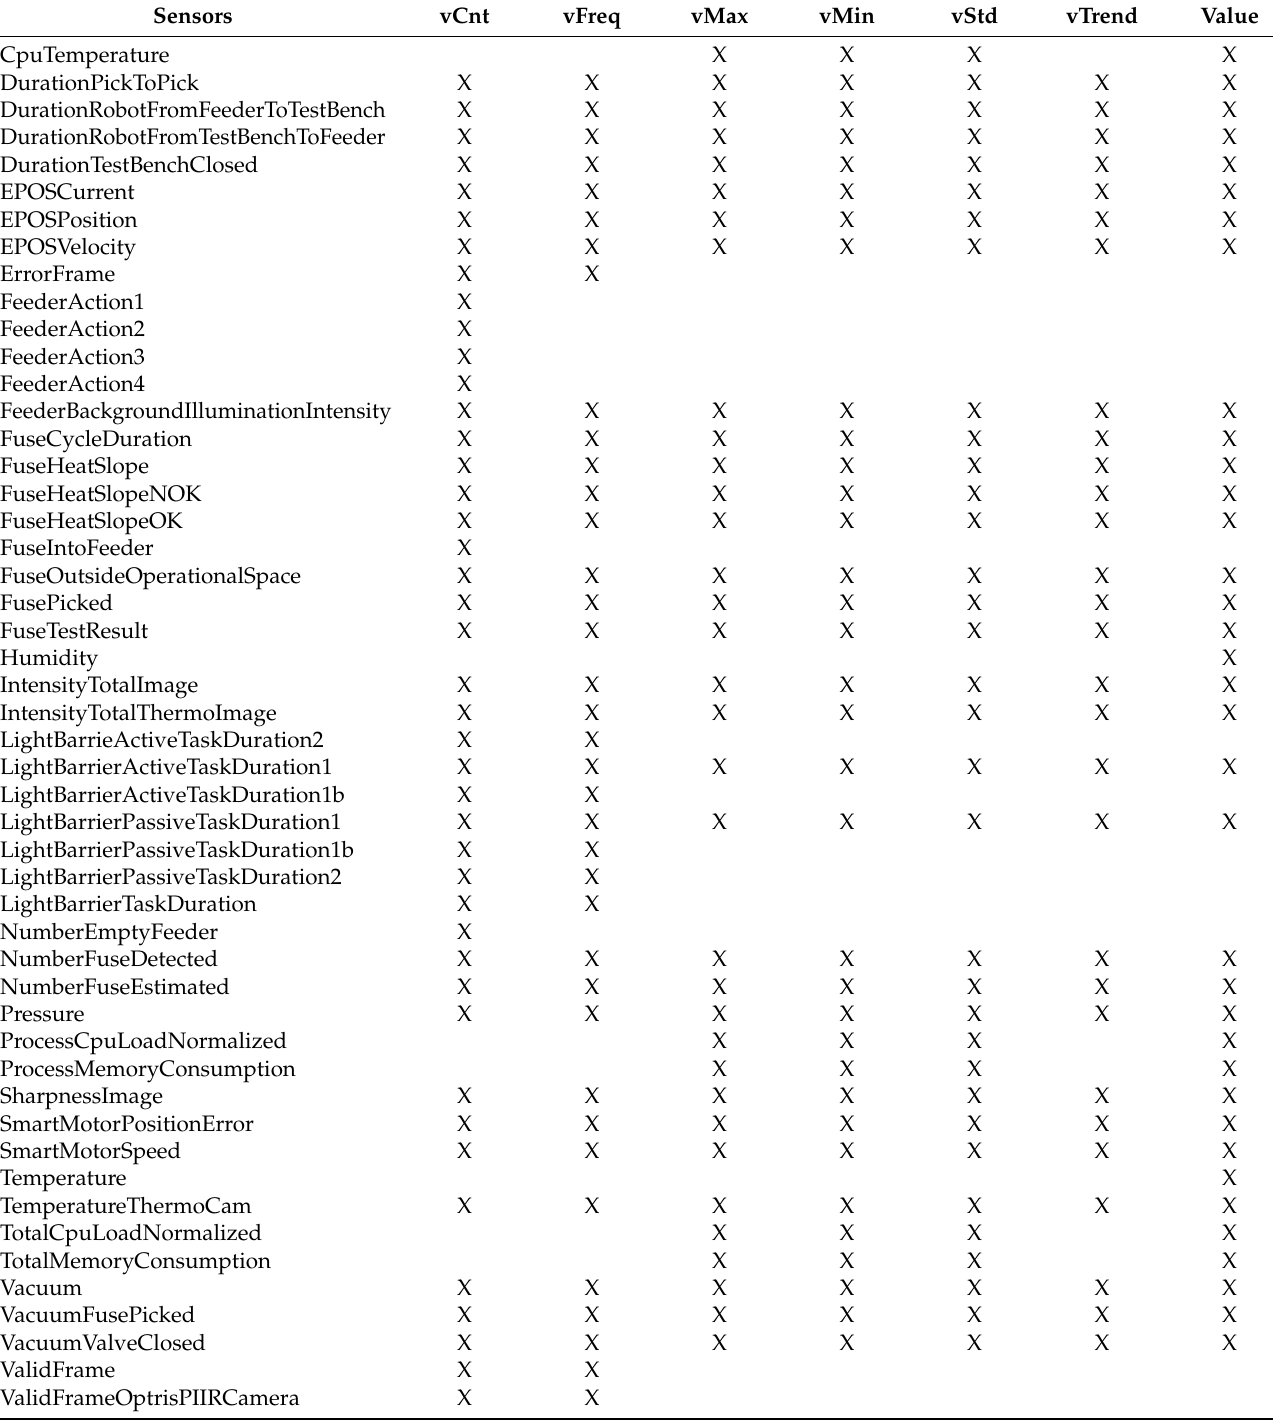
Table A1. List of the signals present in the PHME dataset and the related fields measured per